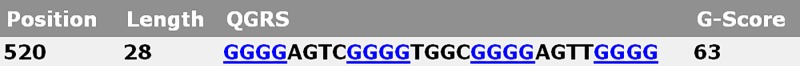
G-quadruplex prediction.QGRS mapper prediction of G-quadruplex for the IGFN1 intron15 displayed a PQS with score 63.